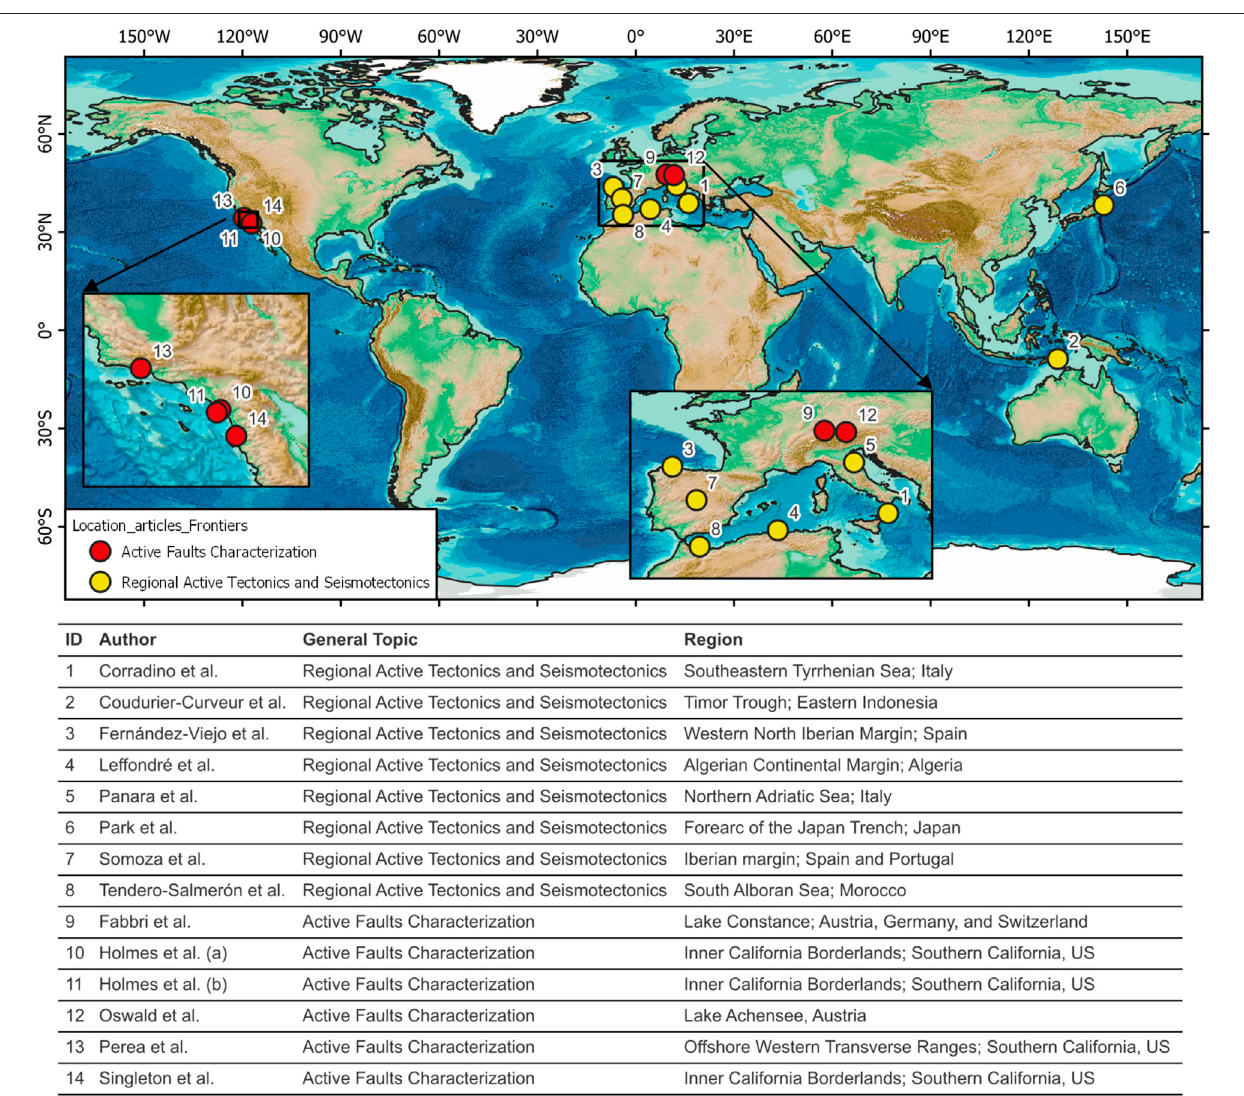
Frontiers in Earth Science |